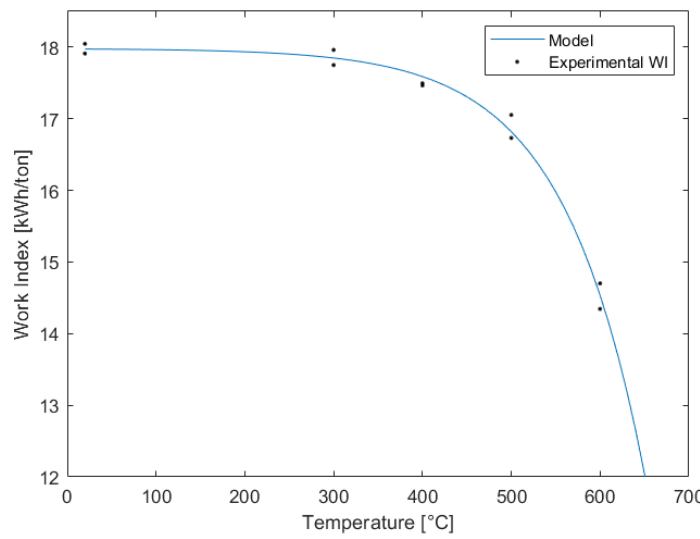
Figure 3. Work index as a function of the pre-treatment temperature.